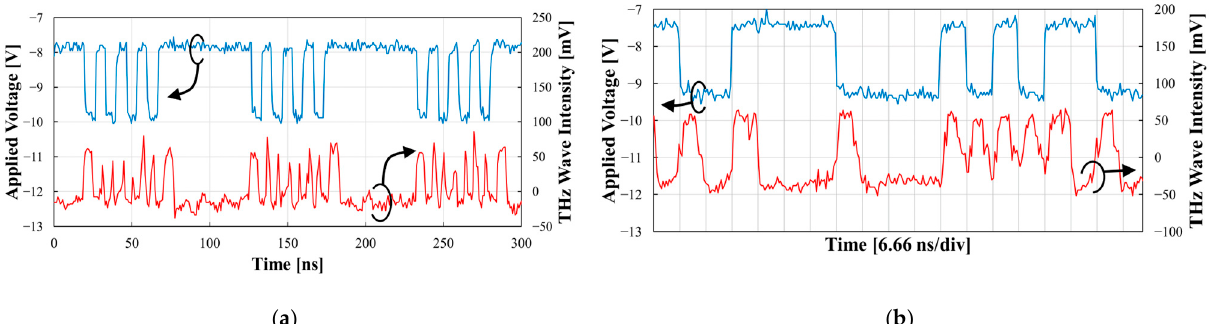
Figure 6. Measured waveform of applied voltage (upper) and the teraher tz -wave intensity (lower). ( a ) at the pa tt ern of “0101010111111111”; ( b ) at the pa tt ern of